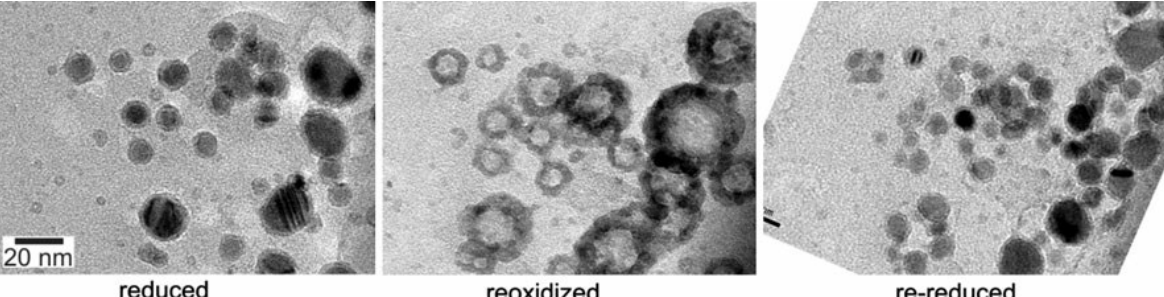
Figure 48. Bright field TEM images showing redispersion of cobalt particles supported on a flat model silica by oxidative treatment. The center image shows hollow spheres created by the Kirkendall effect, which form dispersed smaller particles upon re-reduction in the right hand image. Reproduced from [378]. Copyright 2011,